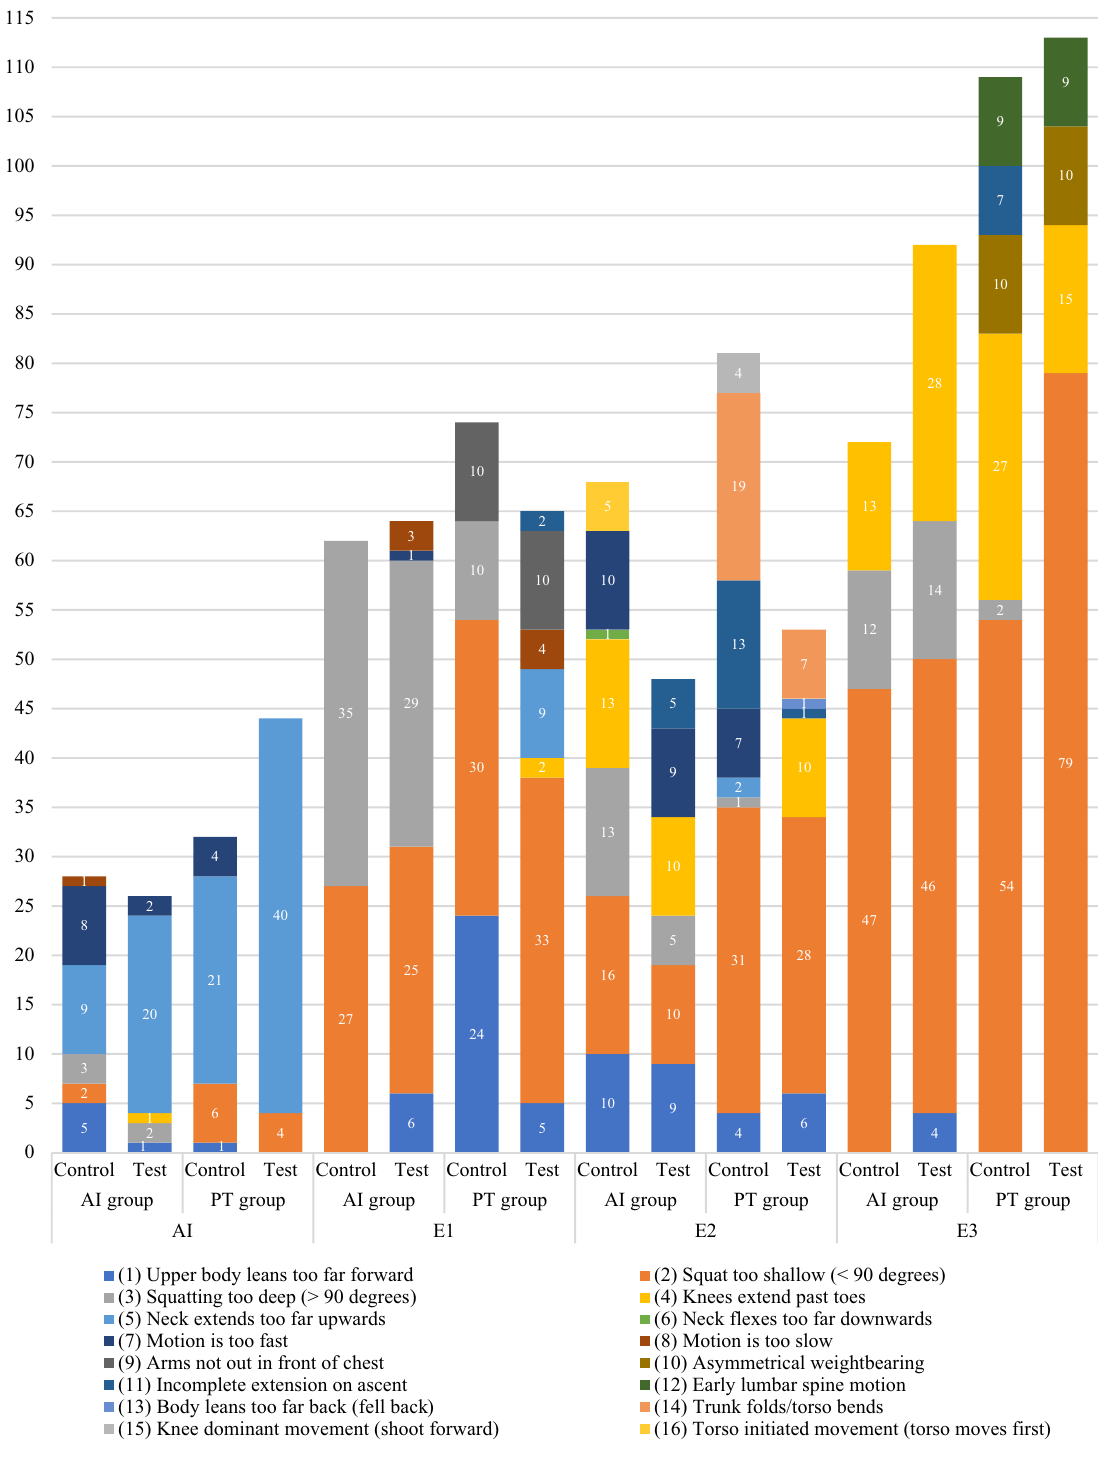
Figure 3. Feedback for incorrect squats as provided by AI and evaluators (E1, E2,